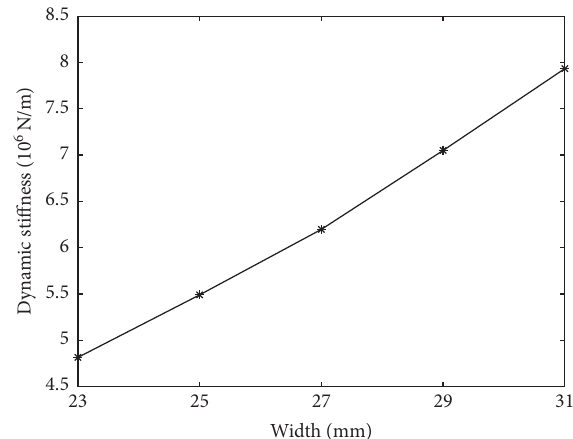
Figure 21: The influence of variations in shaft damping ring width on dynamic stiffness.